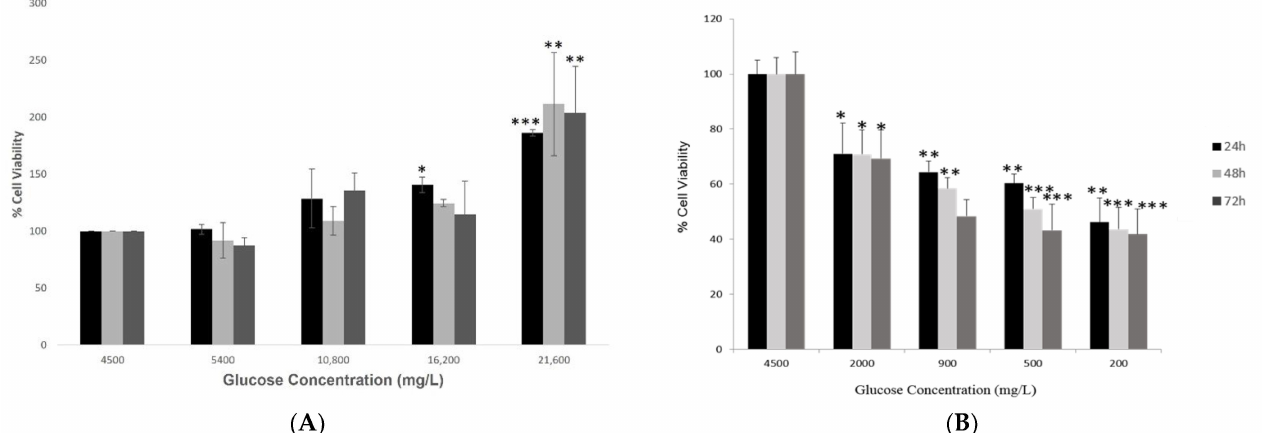
Figure 1. Cell viability of hypothalamic neurons under various glucose concentrations at different time points. ( A ) Increased glucose concentrations (mg/L) of 5400, 10,800, 16,200, and 21,600 (please check) at 24, 48 and 72 h time points enhanced the viability of cells significantly, with maximum percentage (~200%) observed at the highest glucose concentration of 21,600 mg/L compared to the control condition (4500 mg/L). ( B ) Low glucose concentrations (mg/L) of 2000, 900, 500, and 200 at 24, 48 and 72 h time points affected the viability of cells adversely, with a maximum reduction observed at the lowest glucose concentration of 200 mg/L at longest exposure of 72 h as compared to the control condition (4500 mg/L). The effects of decreasing glucose concentrations on the viability of hypothalamic neurons were published previously by our group. Data is represented as mean ± SEM ( n = 3, * p < 0.05, ** p < 0.01, *** p <